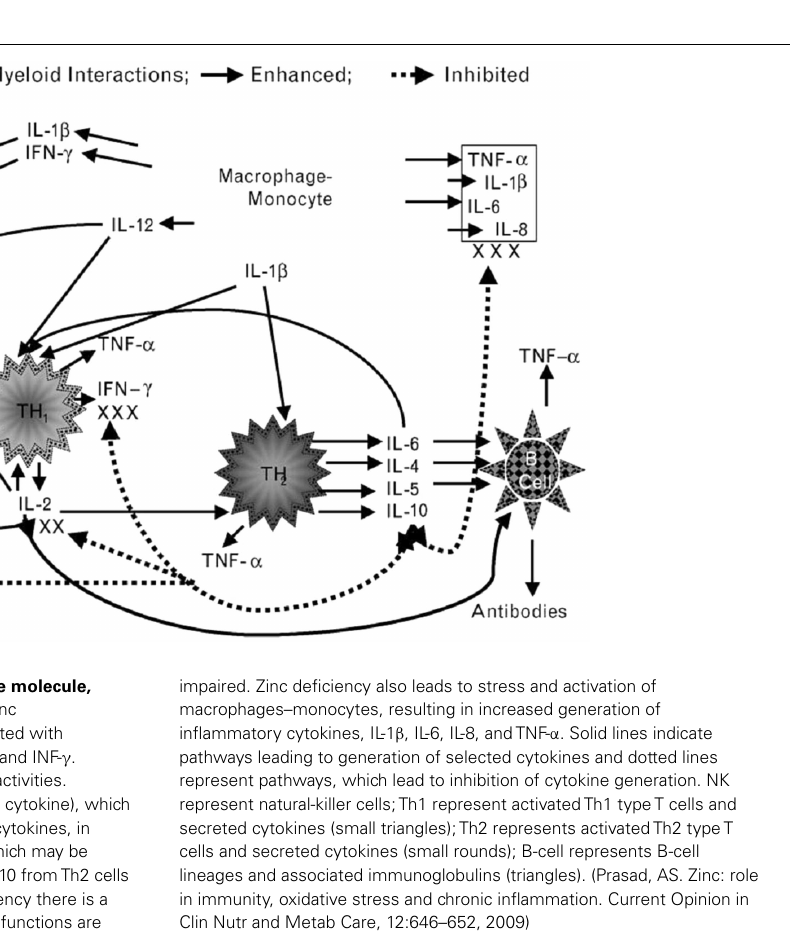
FIGURE 2 | Zinc is an integral part of a thymic hormone molecule, thymulin .Thymulin is required for maturation ofT cells. Zinc deficiency-induced decrease in thymulin activity is associated with decreased maturation ofT cells andTh1 production of IL-2 and INF- γ . Decreased IL-2 leads to decreased NK andT cytolytic cell activities. Macrophages–monocytes produce IL-12 (a zinc-dependent cytokine), which along with INF- γ kills parasites, viruses, and bacteria.Th2 cytokines, in general are not affected by zinc deficiency except IL-10, which may be increased in zinc-deficient elderly individuals. Increased IL-10 fromTh2 cells further affectsTh1 functions adversely.Thus, in zinc deficiency there is a shift fromTh1 toTh2 functions and cell-mediated immune functions are